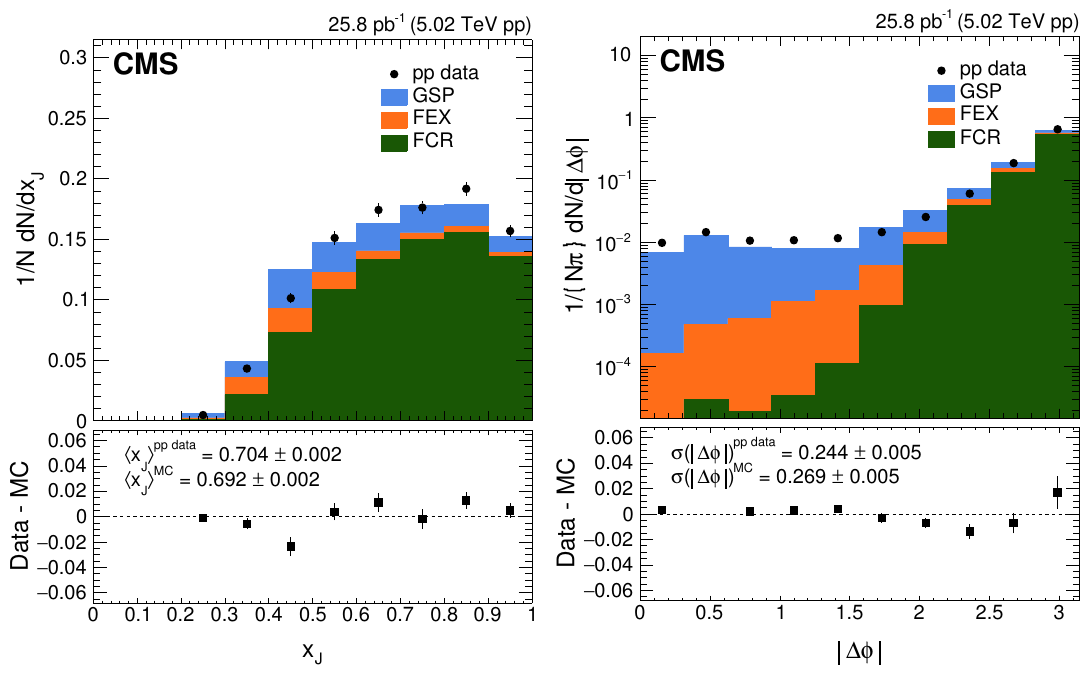
Figure 8 . The distributions of x J (left) and (cid:1) (cid:30) (right) in pp collisions after (cid:13)avor process reweight- ing. Data are shown in solid points, while the stacked histograms show the contributions of di(cid:11)erent processes in pythia 6 (see text for details). The bottom set of panels show the di(cid:11)erence between data and simulation